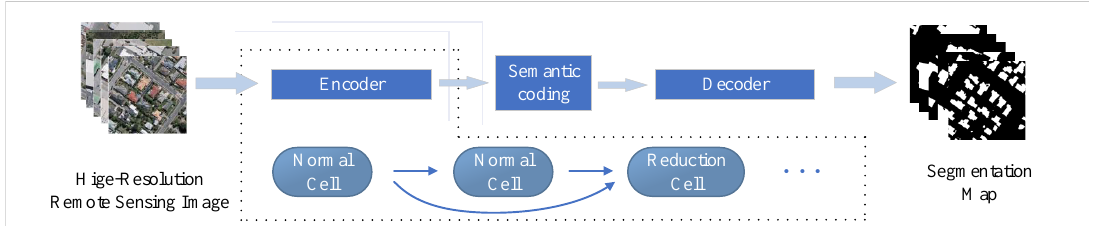
Figure 2. The model uses the encoder-decoder structure. And the encoder is composed of cells which are searched by the